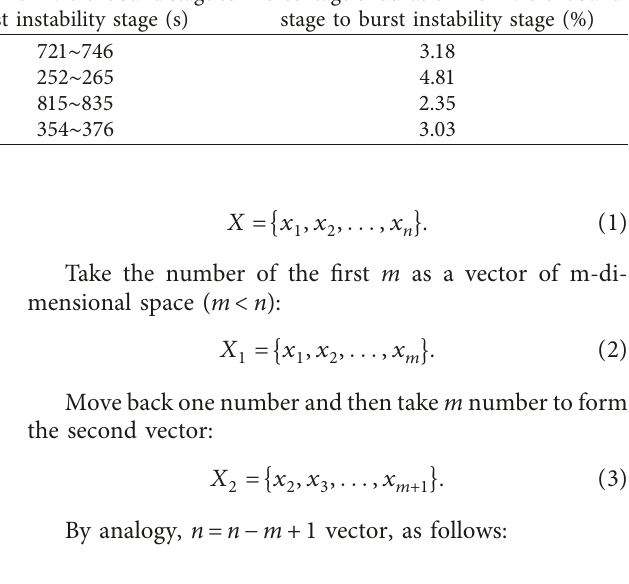
Figure 6: Time series characteristics of AE energy rate and AE cumulative energy of different specimens. (a) Cubic red sandstone. (b) Cylindrical red sandstone. (c) Cubic granite. (d) Cylindrical granite. Table 2: Time ratios of each stage in the rock burst process of different specimens.